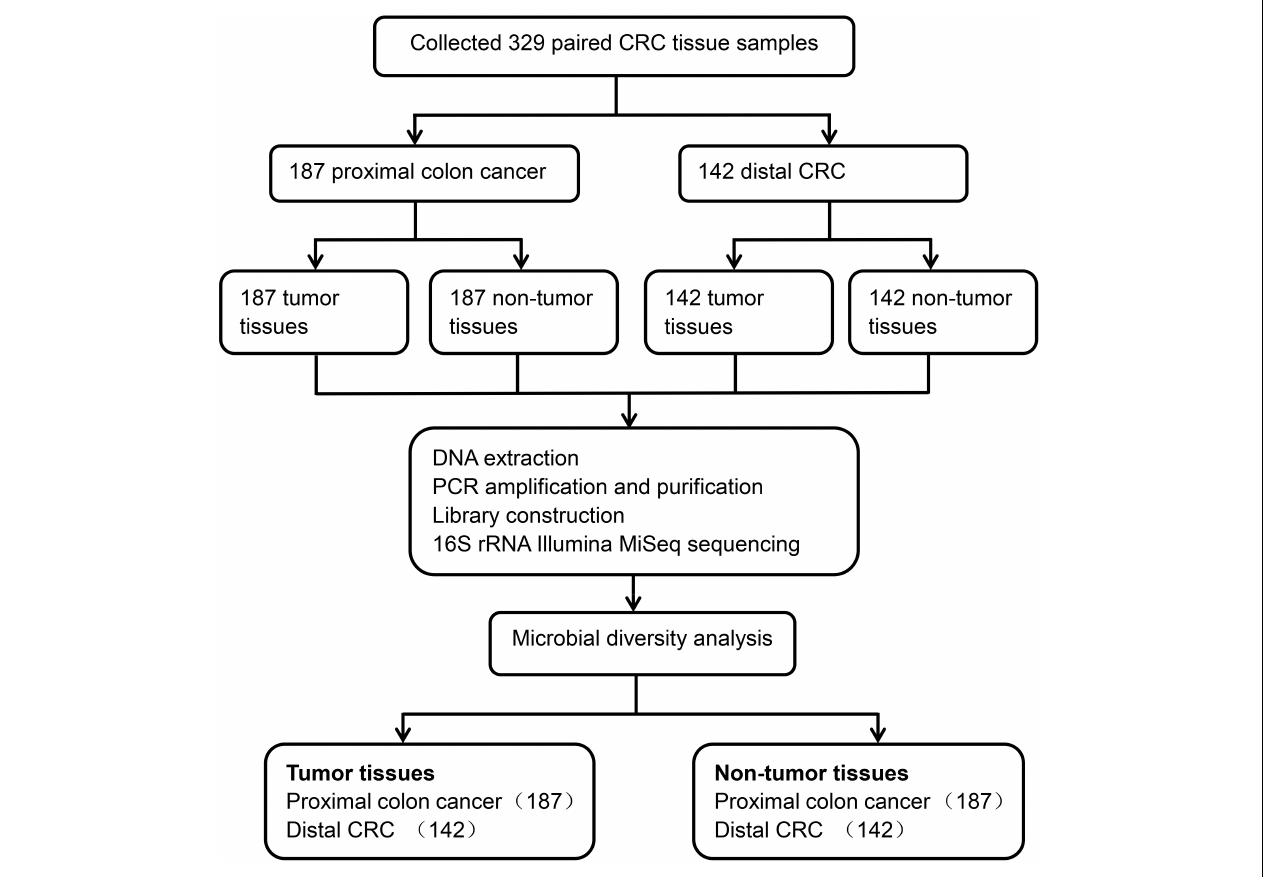
FIGURE 1 | Study design and flow